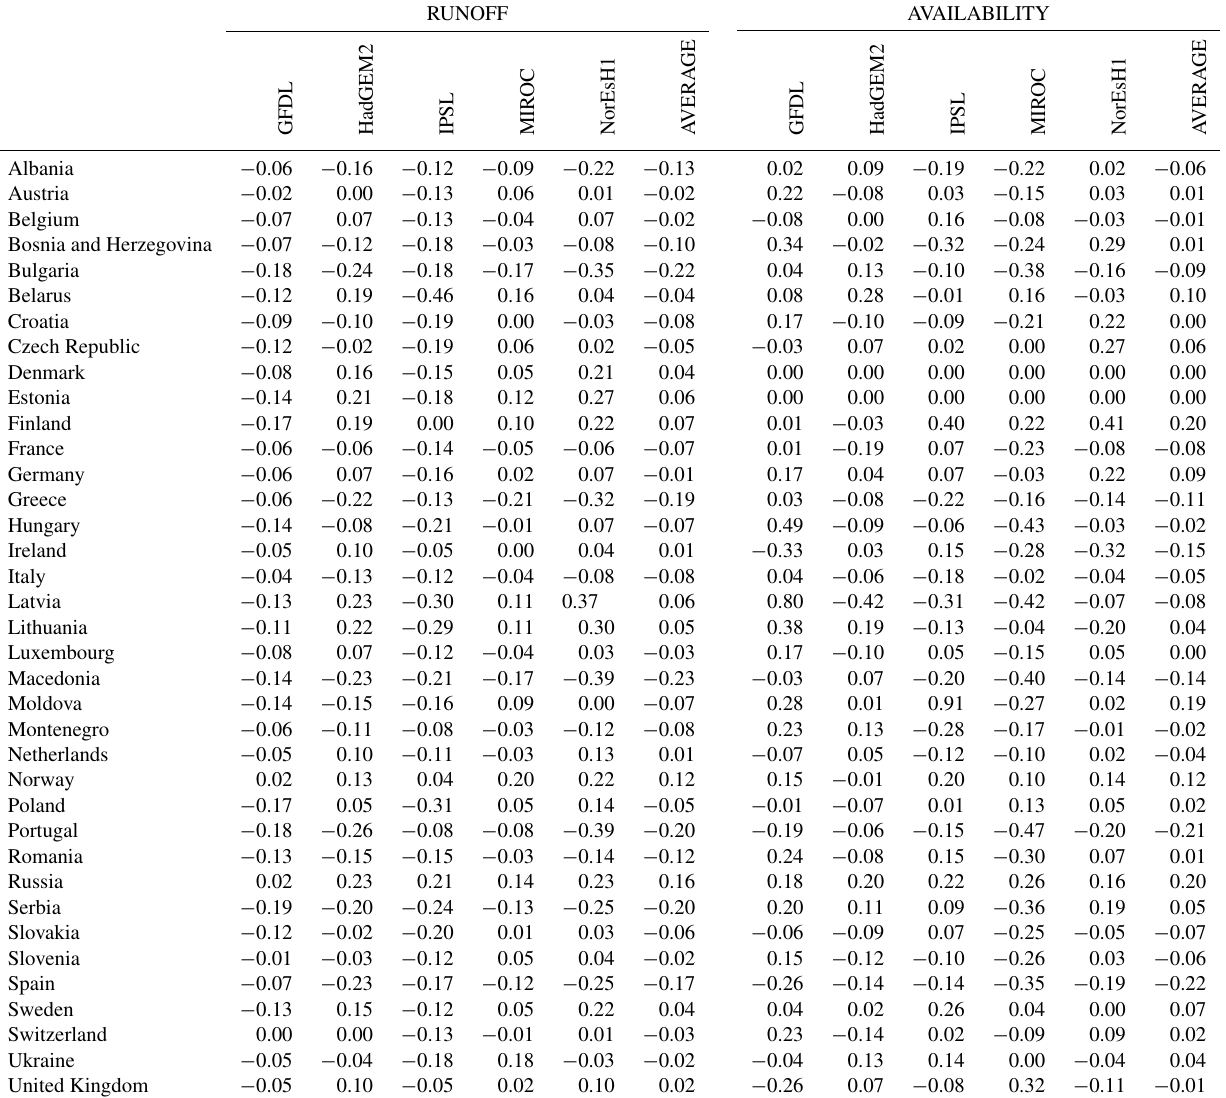
Table 1. Country estimates of changes in average runoff and surface water availability in the long term period (2060–2099) with respect to the control period (1960–1999) under emission scenario RCP4.5. Results show the five GCM 40 forcing models considered and the average